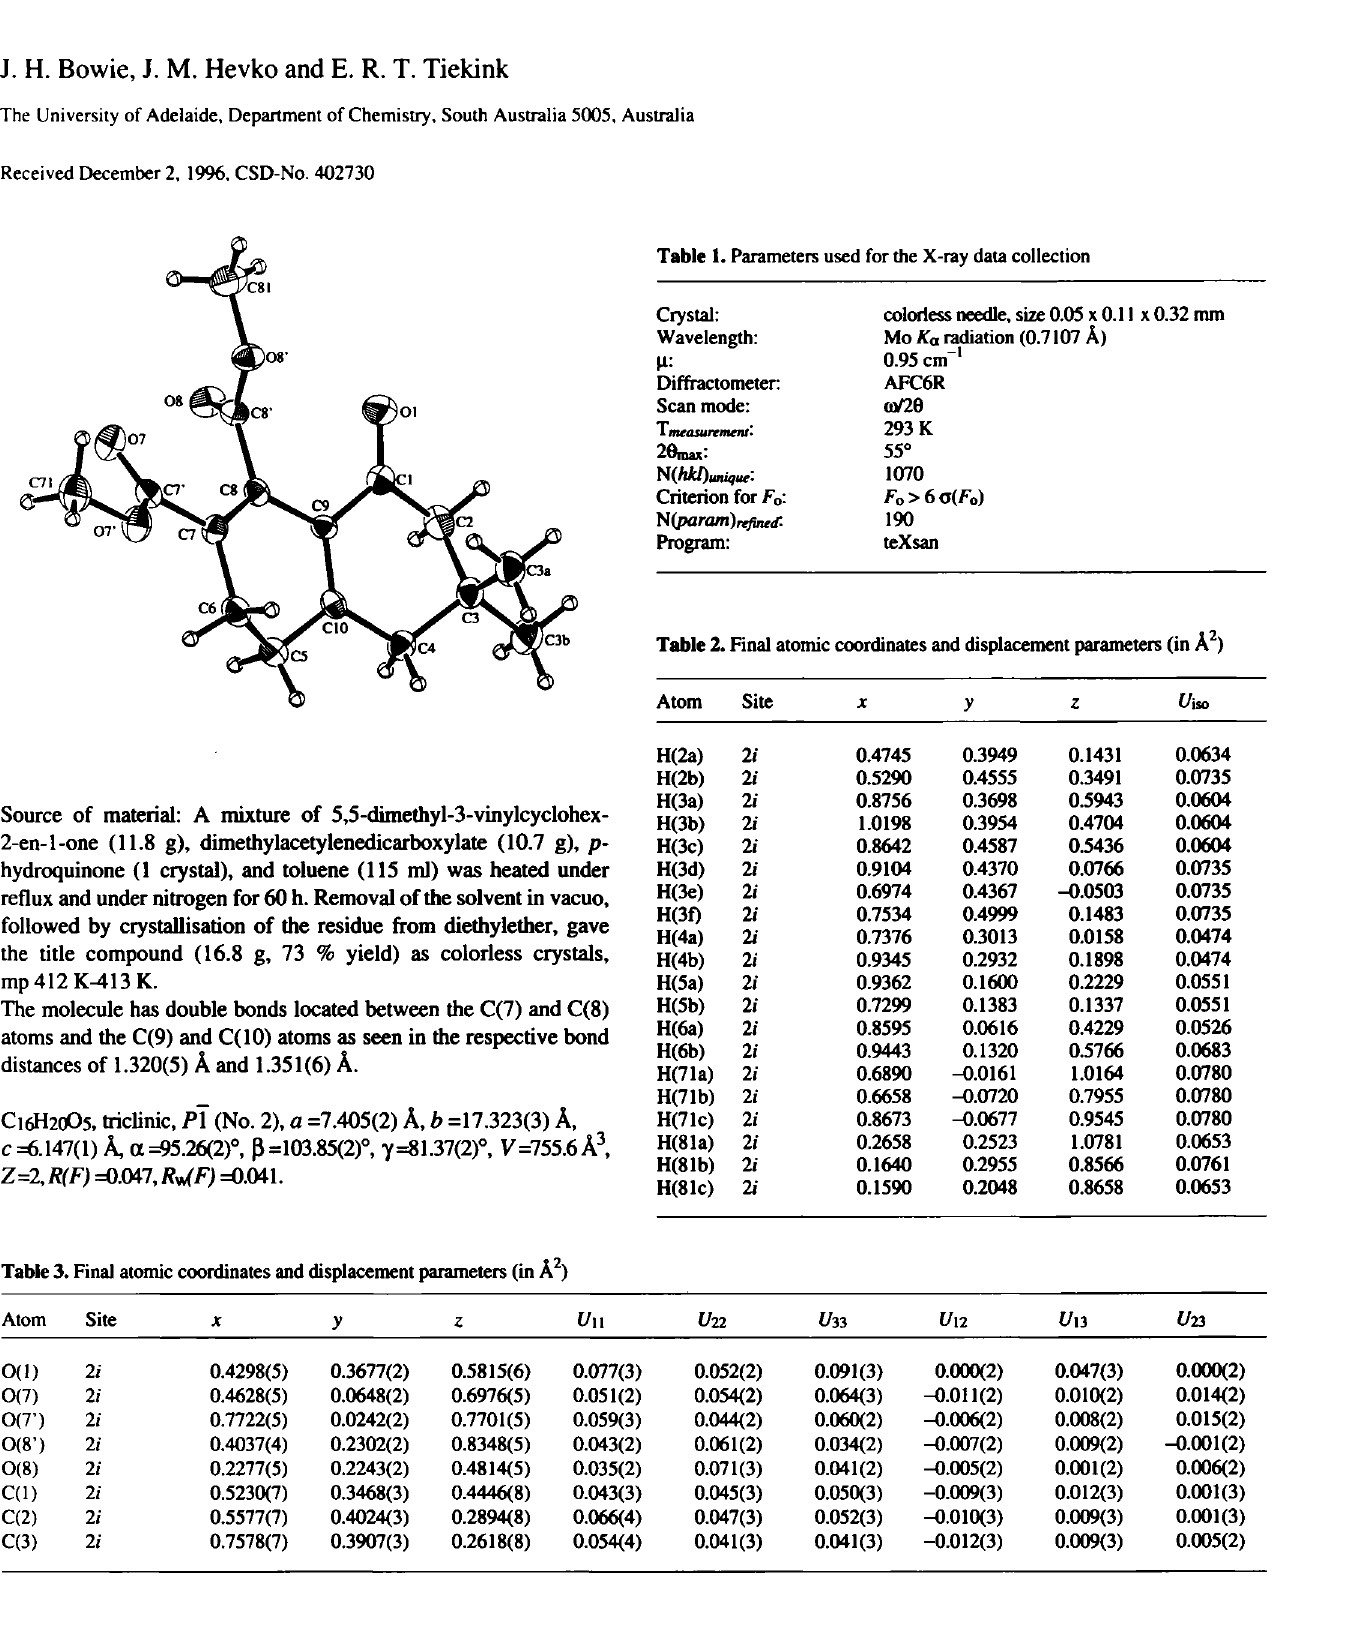
Table 1. Parameters used for the X-ray data collection